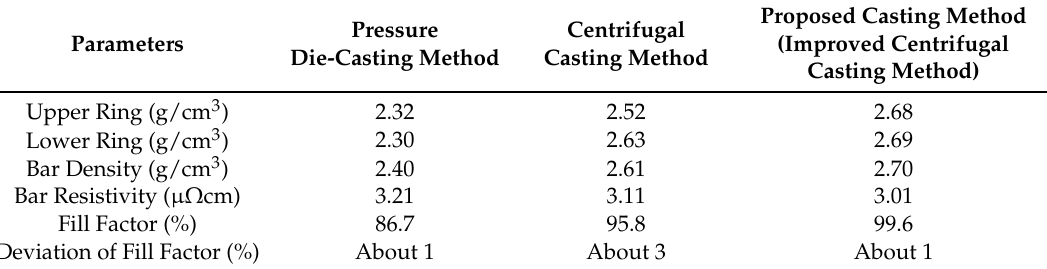
Table 4. The densities and fill factors of the three types of